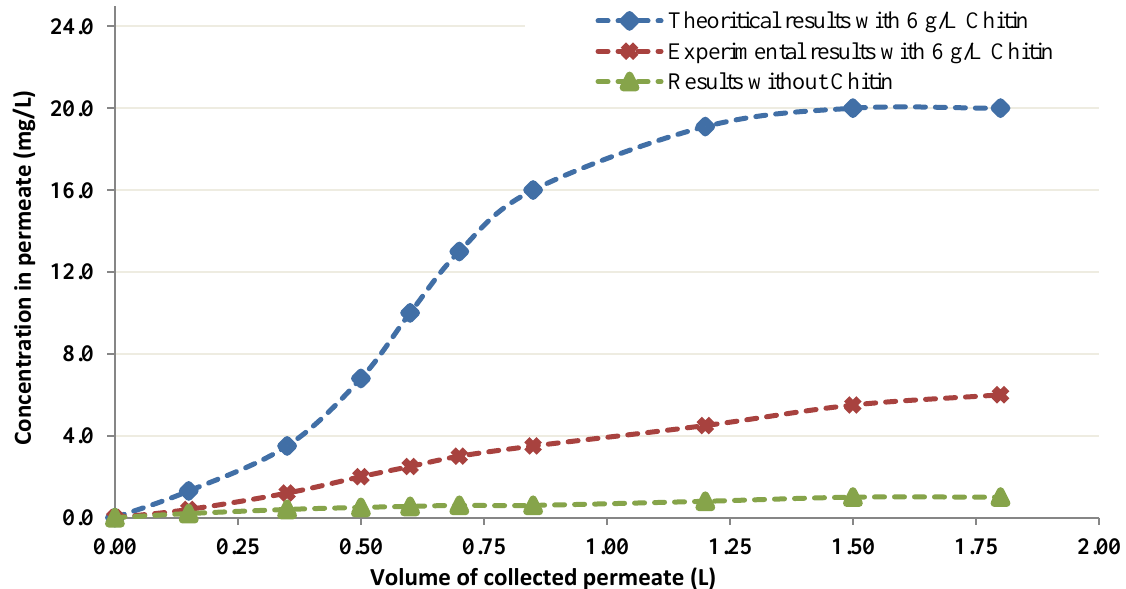
Figure 10. Permeation curve of chitin at 6 g/L with predicted curve at 6 g/L. In Figure 10, the green triangles show the empirical details without Chitin, and the violet stars depict the determined levels of Cobalt with 6 g/L Chitin into the effluent. The calculated levels are directly determined by utilizing Equation (3). The empirical details attained for CEFP with 6 g/L Chitin are denoted by blue squares. All experiments are performed by using a feed with measured concentration of cobalt (20 mg/L).